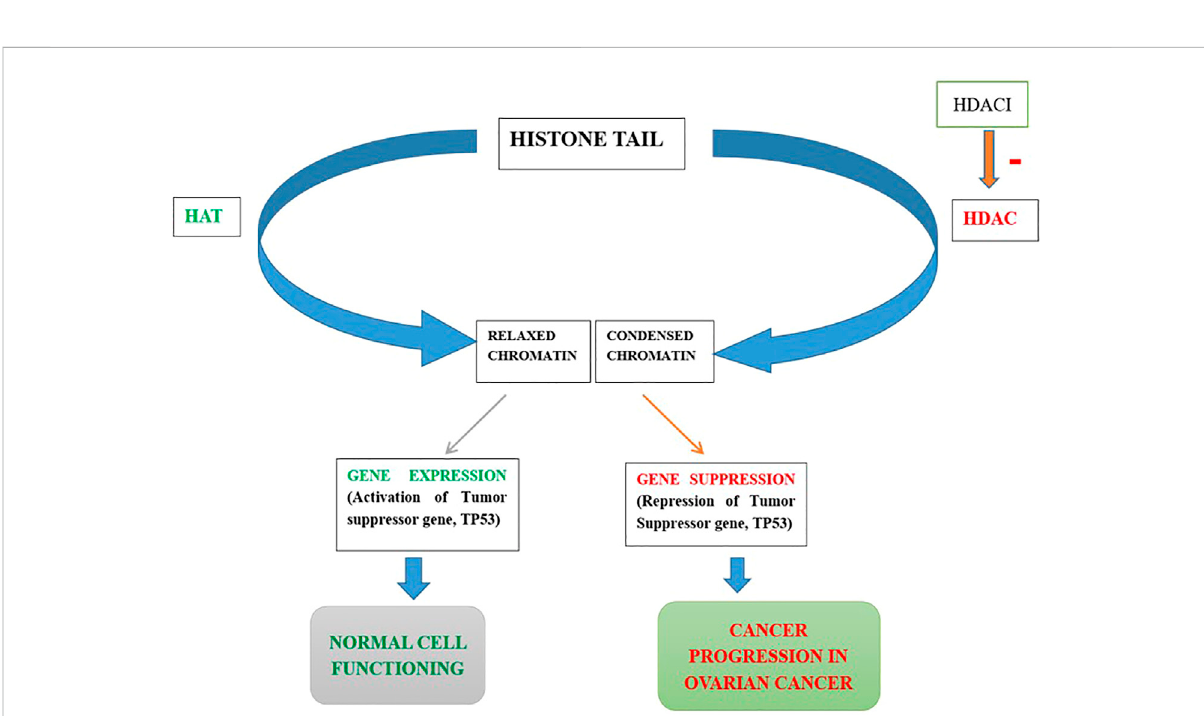
regulation of endothelial nitric oxide synthase (eNOS) in endothelial cells (Eckschlager et al., 2017). The combination of VPA, 5- Azacytidine and carboplatin has been studied by